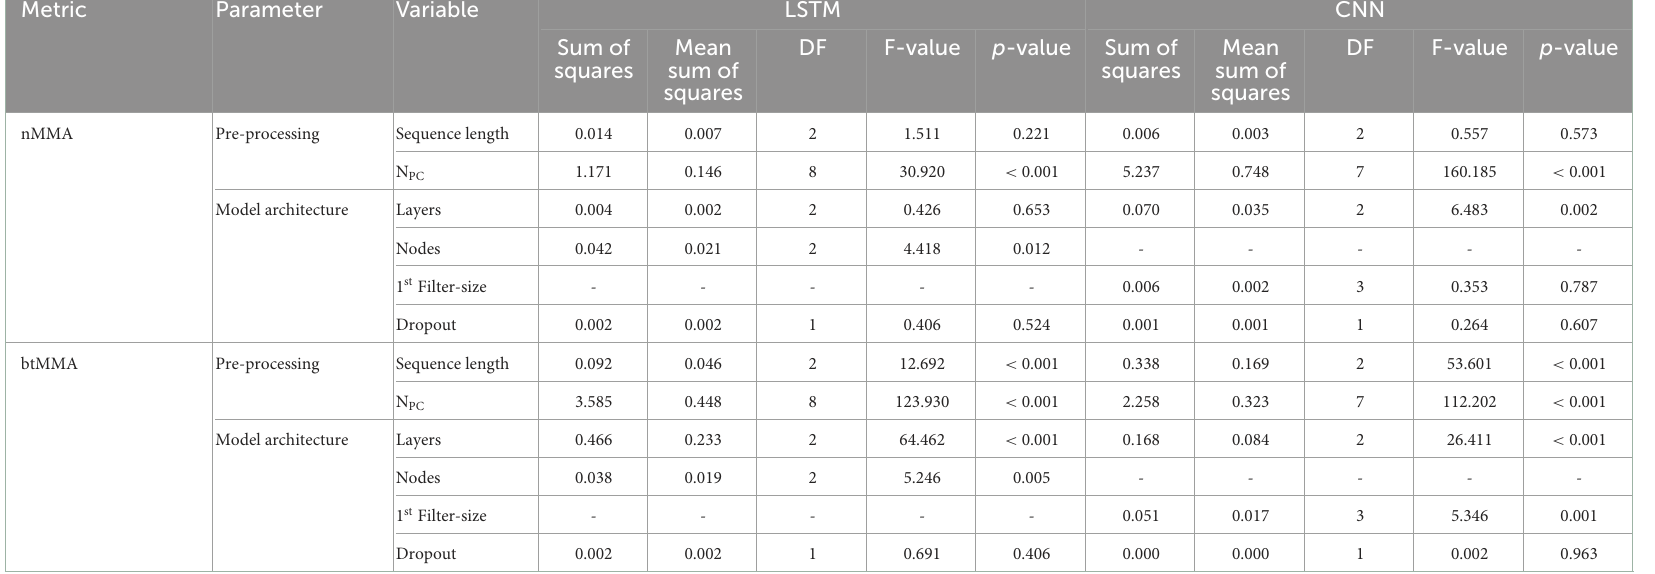
TABLE 5 Results of ANOVA analysis on the effect of the various parameter regarding data pre-processing and model architecture for nMMA and btMMA.